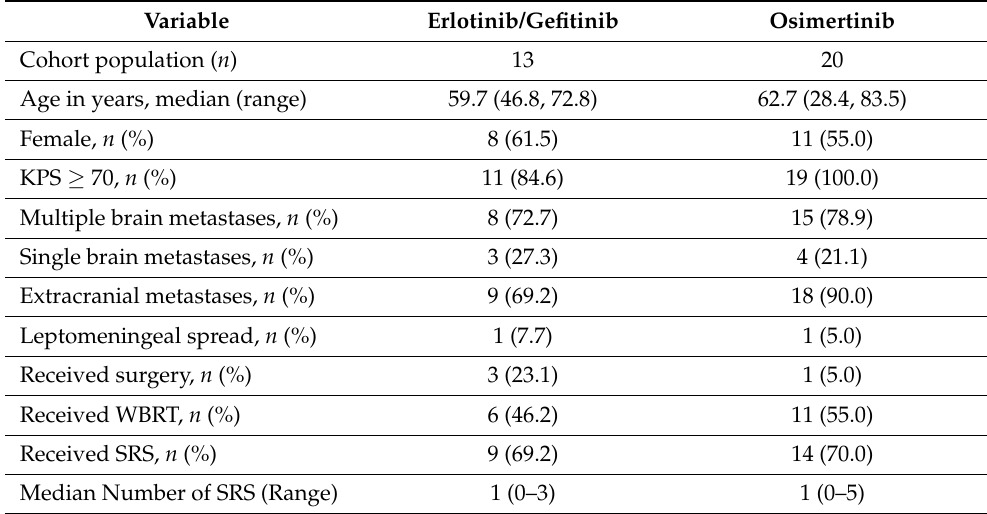
Table 3. Characteristics of patients with NSCLC brain metastases who received line EGFR-directed Tyrosine Kinase Inhibitors (EGFR-TKIs) in later (2nd to 5th) lines of